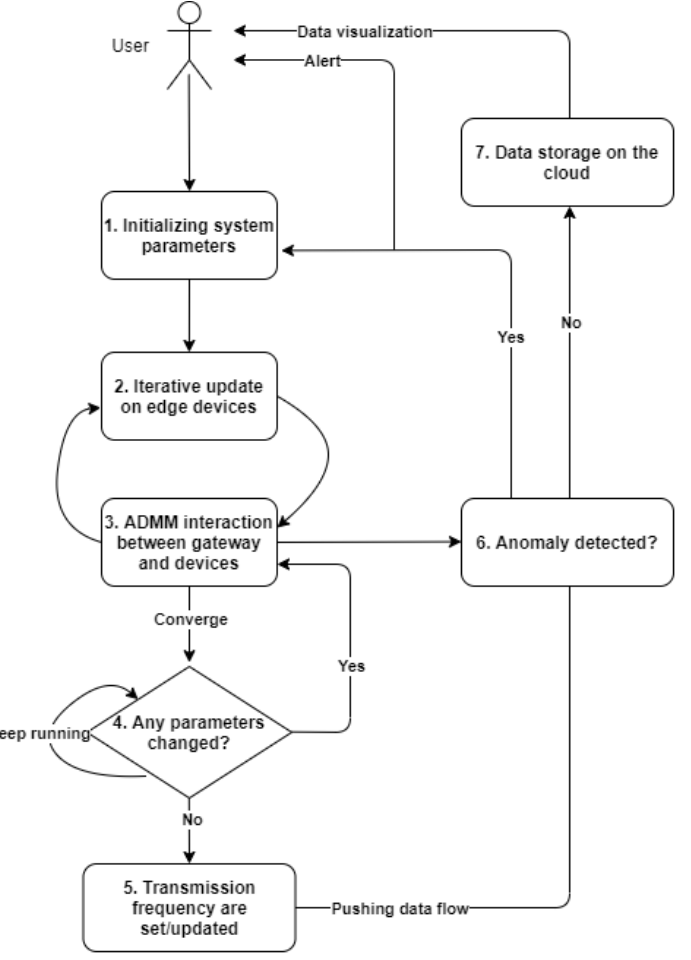
Figure 2. System implementation flowchart